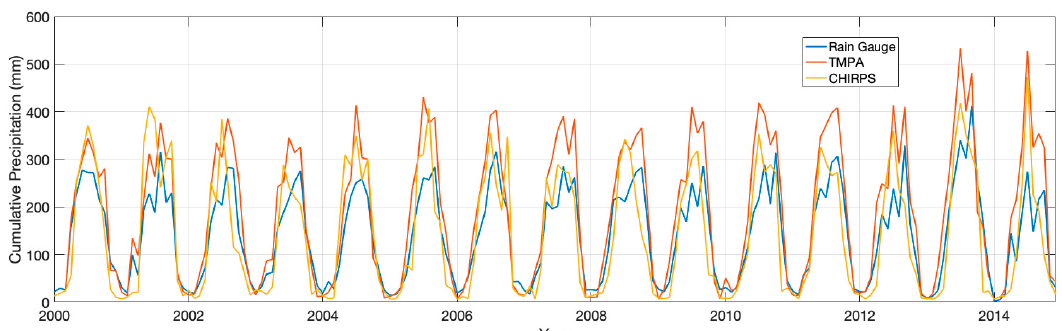
Figure 5. Time-series comparison of monthly averages from in-situ data and TMPA and CHIRPS satellite-based precipitation estimates from 2000 to 2014. Table 3. Comparison statistic results between rain gauge measurements and satellite-based precipitation estimates for monthly rainfall categorized on the basis of elevation for R, bias, MAE, and RMSE.